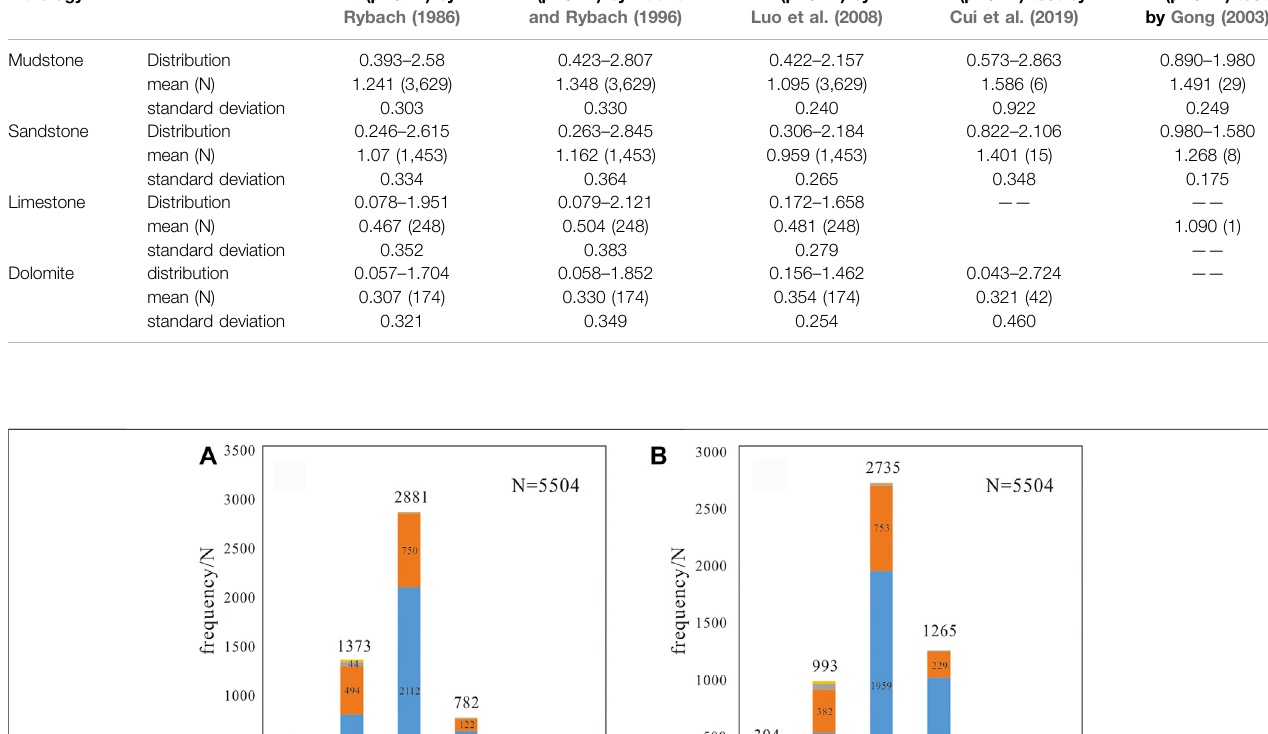
Frontiers in Earth Science |